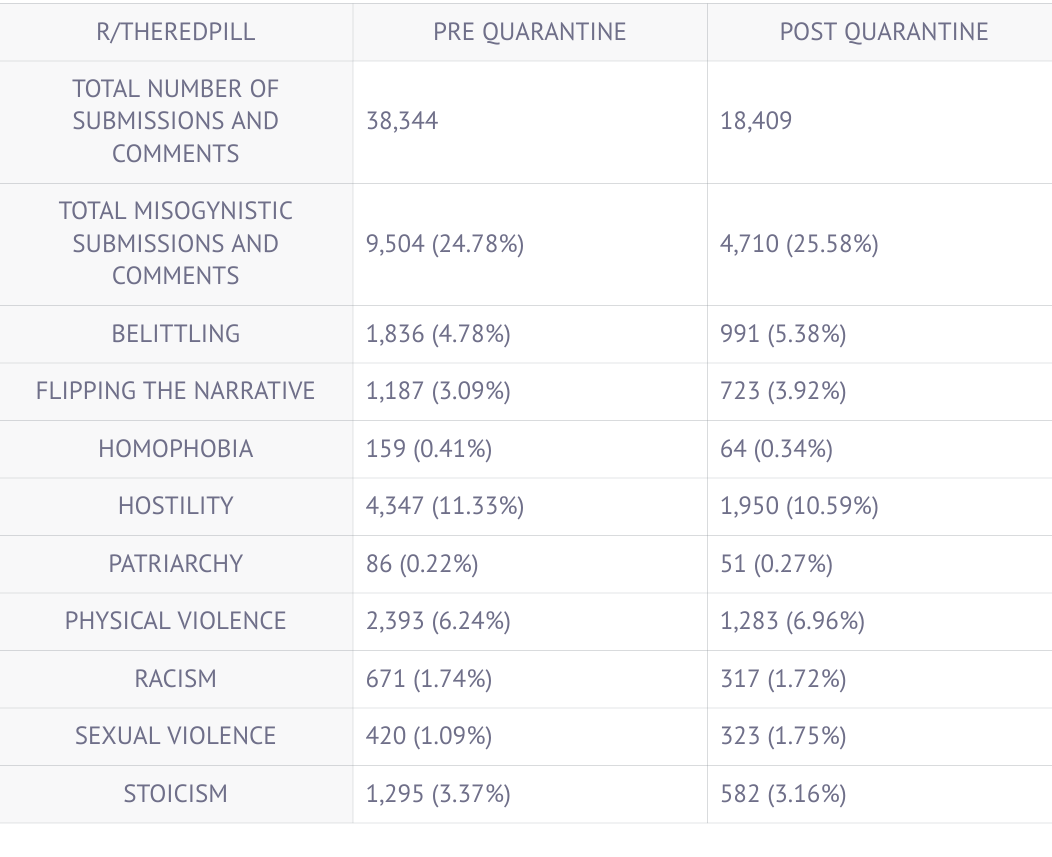
TABLE 1: Misogynistic language analysis for r/TheRedPill R/THEREDPILL